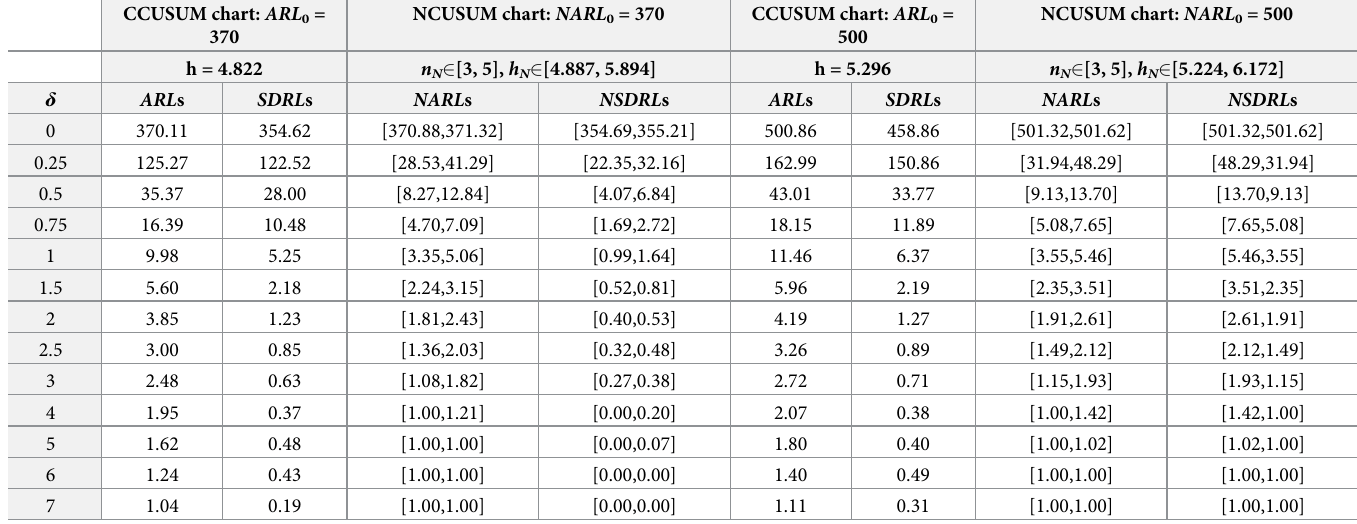
Table 7. Comparison of the NCUSUM and the classical CUSUM (CCUSUM) � X charts when k = 0.5, k N ∈ [0.4, 0.5]. NCUSUM chart: NARL 0 = CCUSUM chart: ARL 0 = 370